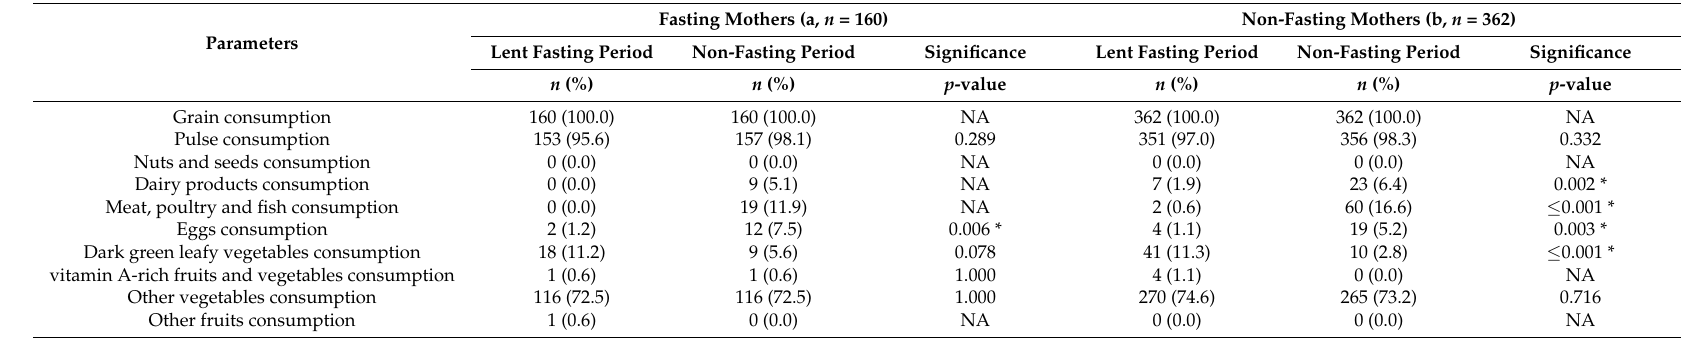
Table 5. Food consumption and anthropometric status of fasting and non-fasting mothers, during Ethiopian Orthodox lent fasting and non-fasting periods in rural Tigray, Northern Ethiopia.